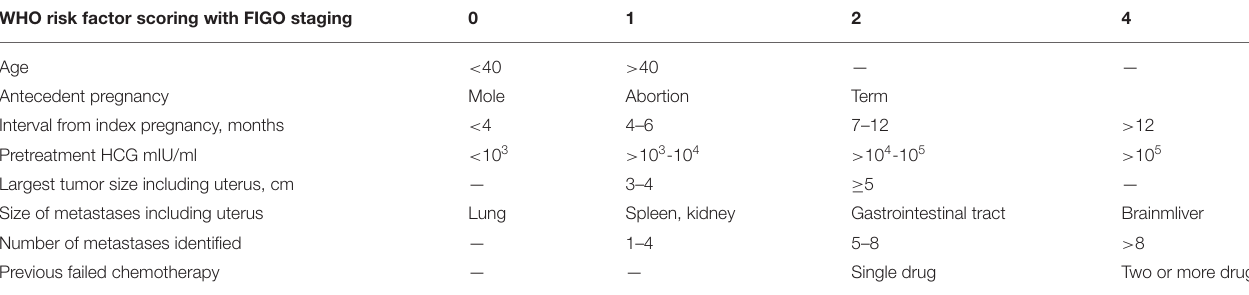
TABLE 1 | WHO scoring system based on prognostic factors. WHO risk factor scoring with FIGO staging 0